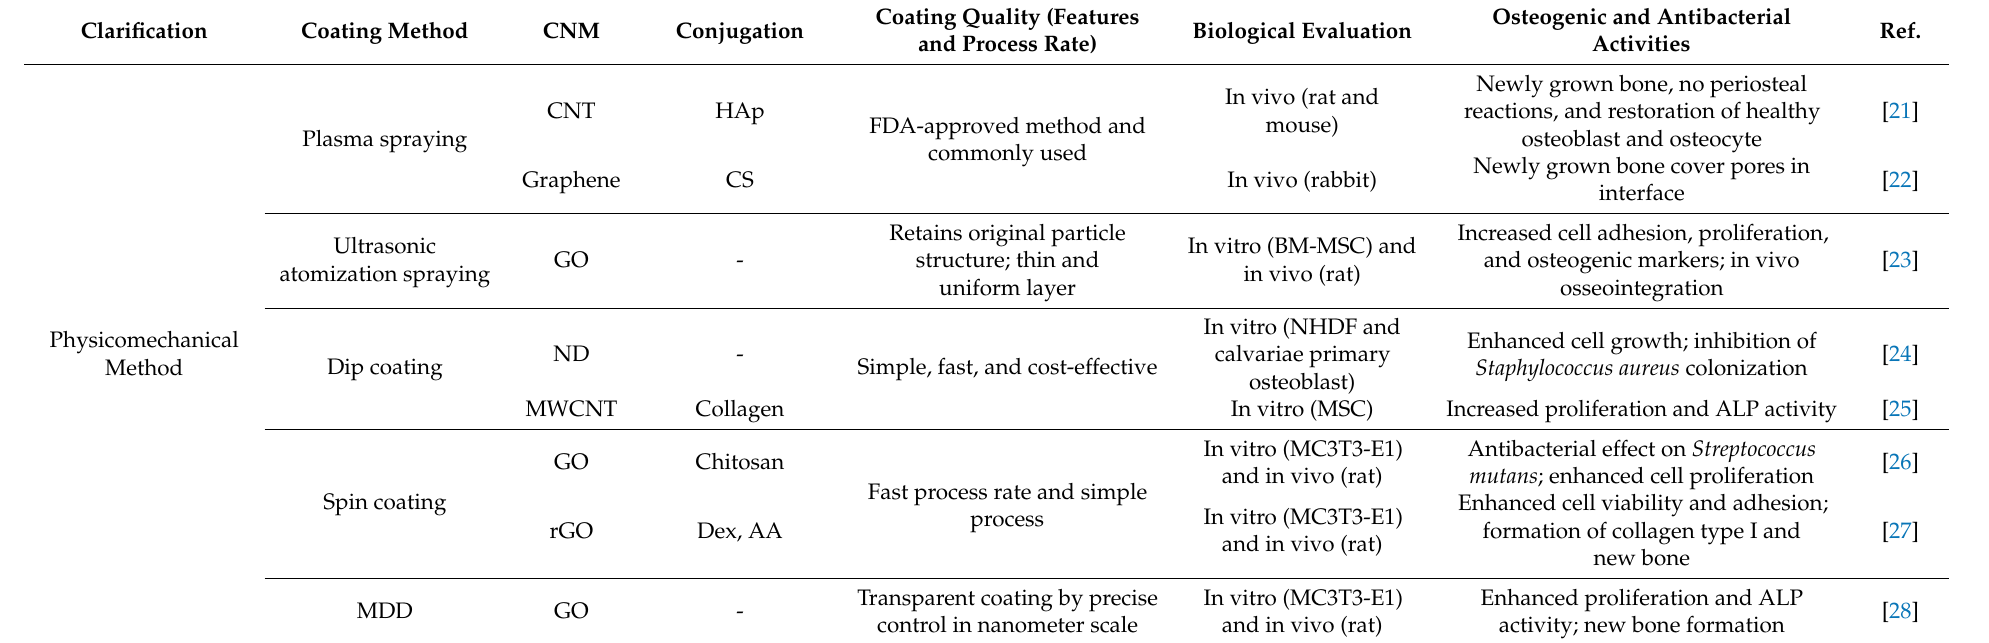
Table 1. Recent studies on CNM-based coatings for orthopedic and dental implants are classified by the coating method, kind of CNM, conjugation, coating quality, biological evaluation, and osteogenic and antibacterial